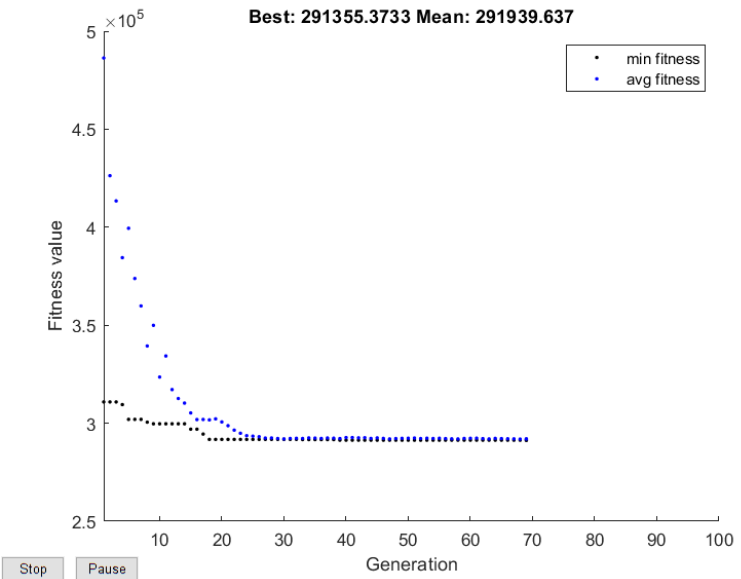
Figure 7. Best and average fitness evolution in control strategy #1 when minimizing V (cid:2925)(cid:2932)(cid:2916) .